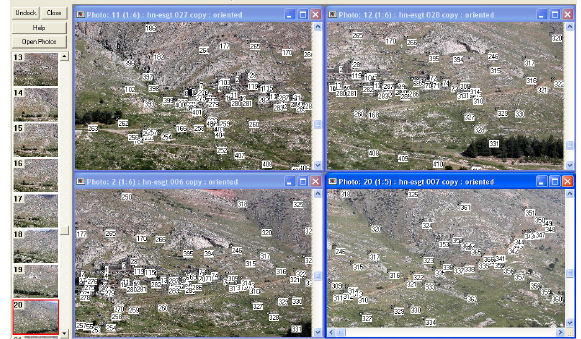
Figure 10. The Photomodeler project to survey with accuracy features in Hosn-Niha landscape. © J. Yasmine;